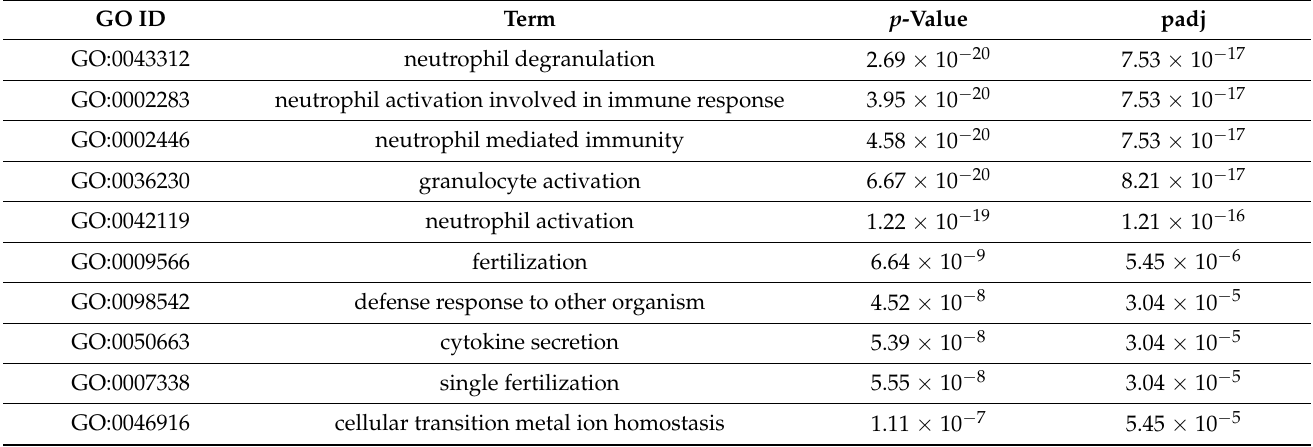
Table 2. List of crucial significant Gene Ontology terms (Slow freezing vs.